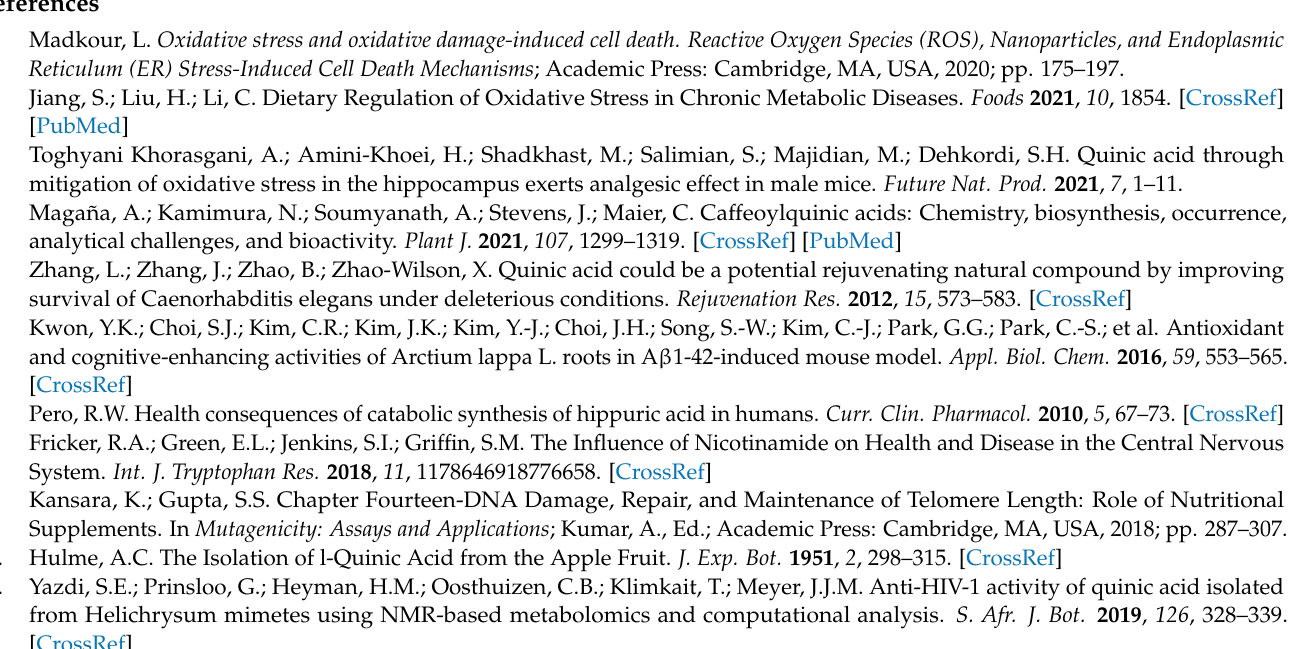
isotherms of (A) MIP A, (B) NIP A, (C) MIP B and (D) NIP B. Figure S17: (A) Pseudo-first order kinetics and (B) pseudo-second order kinetics for MIP C. Figure S18: Freundlich isotherm for MIP C. Figure S19: Calibration curve of QA in methanol over the concentration range of 0.001–0.2 mM. Figure S20: Calibration curve for QA in ethanol over concentration range of 0.2–40 µ g/mL. Table S1: The calculated binding energies for complexes prepared in solvent phase. Table S2: Intra-day and Inter-day precision of QA determination in UPLC-MS/MS method. Table S3: Accuracy of QA determination in UHPLC-MS/MS method. Table S4: %RSD of inter-day and intra-day precision assay for UHPLC measurements. Table S5: Recovery % of spiked QA amount 1x, 2x, and 3x the amount of QA present in coffee extract (10, 20, and 30 µ